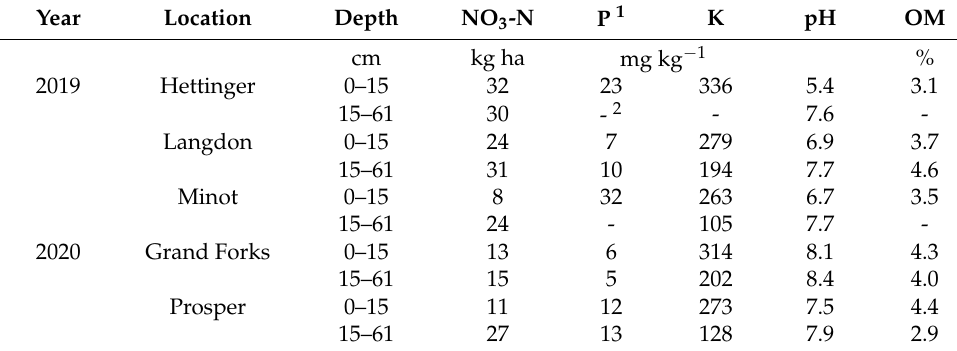
Table 4. Soil test results for all wheat environments in 2019 and